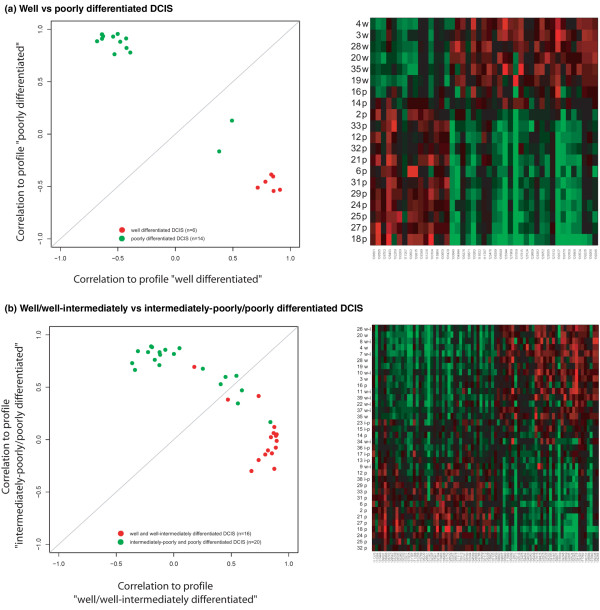
Correlation plots and heatmaps of the in situ samples using the classifiers obtained after cross-validation. (a) Well- (n = 6) versus poorly (n = 14) differentiated ductal carcinoma in situ (DCIS). The classifiers consist of 43 genes. (b) Well-/well-intermediately (n = 16) versus intermediately-poorly/poorly (n = 20) differentiated DCIS using a classifier of 78 genes. i-p, intermediately-poorly differentiated; p, poorly differentiated; w, well differentiated; w-i, well-intermediately differentiated.